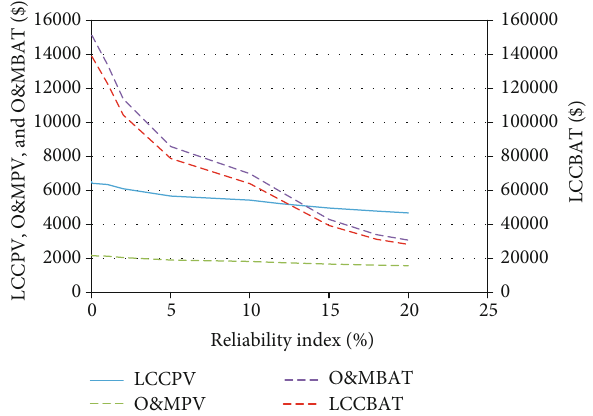
Figure 5: Total life cycle cost and loss of load probability vs. reliability indexes in the optimal condition.